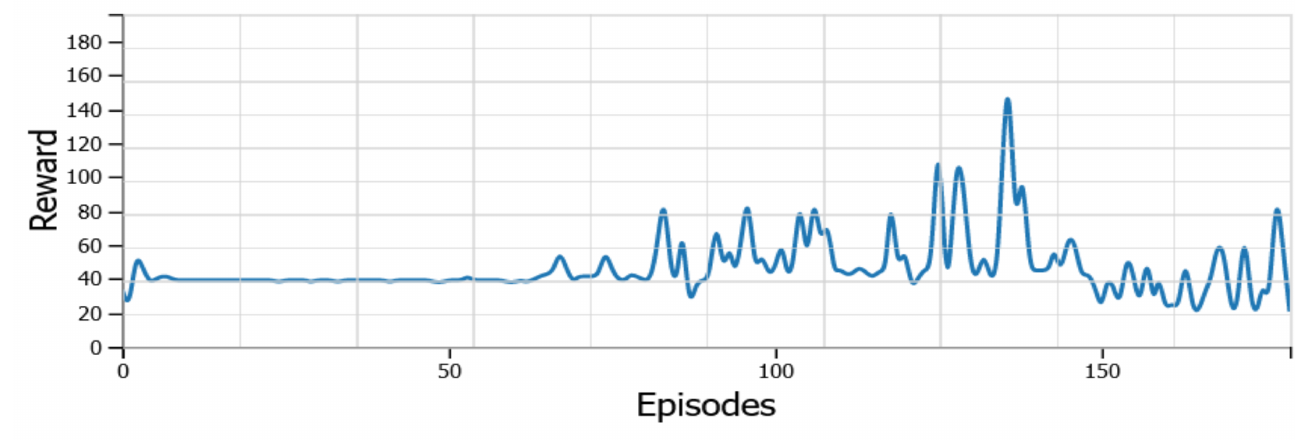
Figure 7. Energy management system applied by deep reinforcement learning.